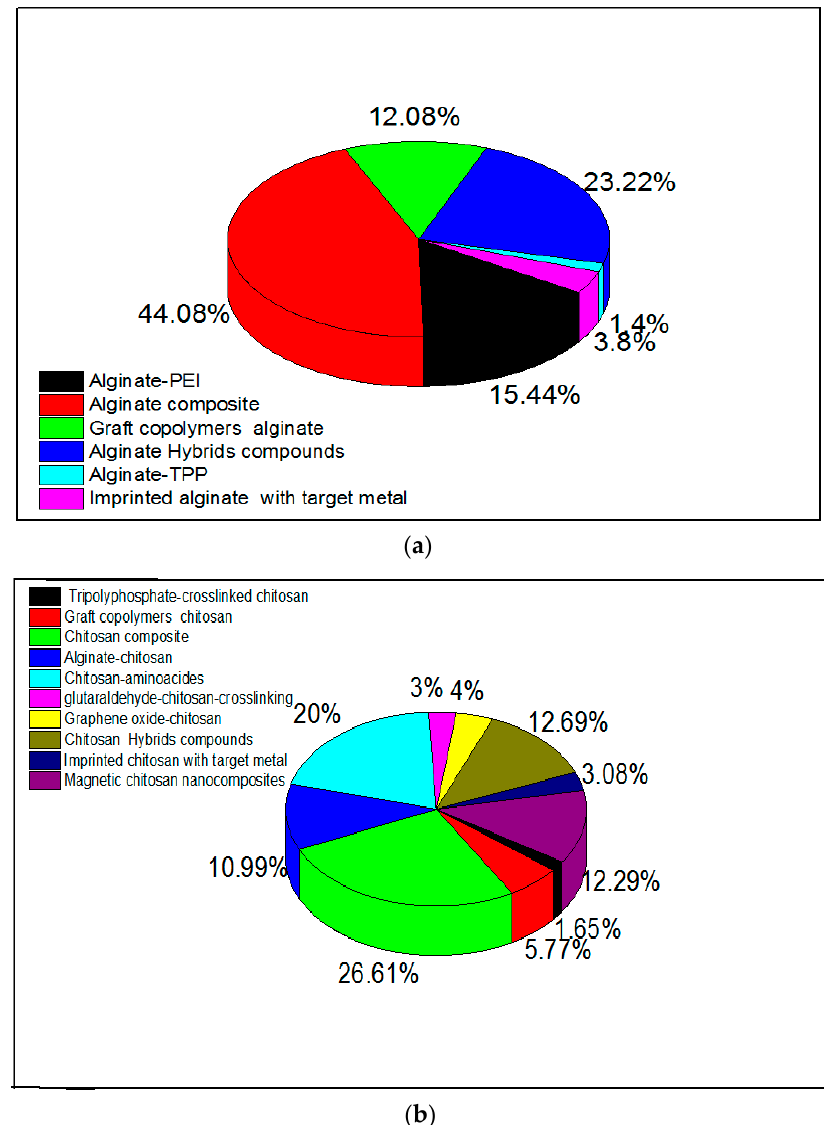
Figure 1. Research interest in ( a ) alginate-based and ( b ) chitosan-based adsorbents for metal ions. Data were obtained from ScienceDirect using different keywords which are represented in the fig- ure.